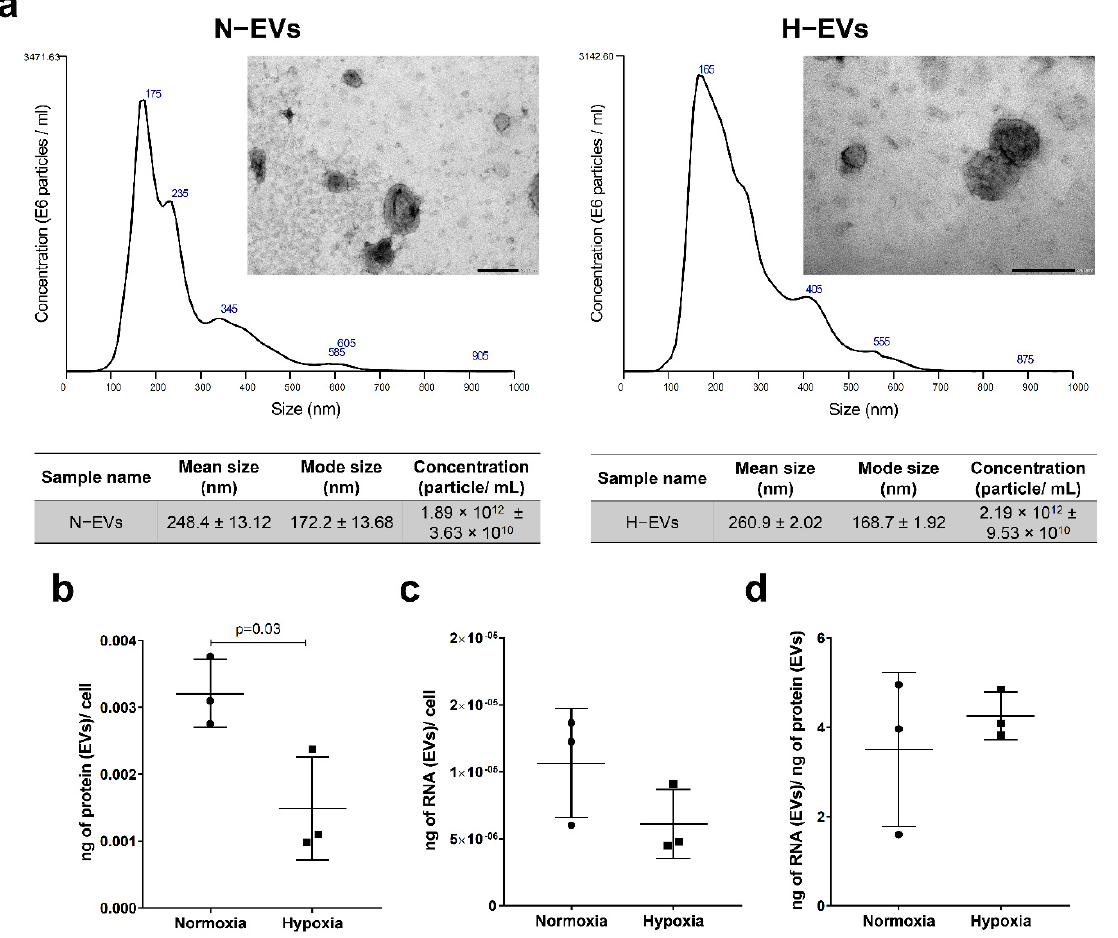
Figure 1. E-CD133 cell and EVs under normoxia and hypoxia. ( a ) Transmission electron microscopy and NTA showing the size distribution of E-CD133 N-EVs and H-EVs ( n = 3 technical replicates). Scale bar = 200 nm. Analysis of ( b ) the ratio of the protein content of the E-CD133 EVs/cell, ( c ) the ratio of the RNA content of the E-CD133 EVs/cell, and ( d ) the ratio of the RNA content/protein content of the E-CD133 EVs obtained from cells cultivated under normoxia and hypoxia. (Unpaired student t -test).